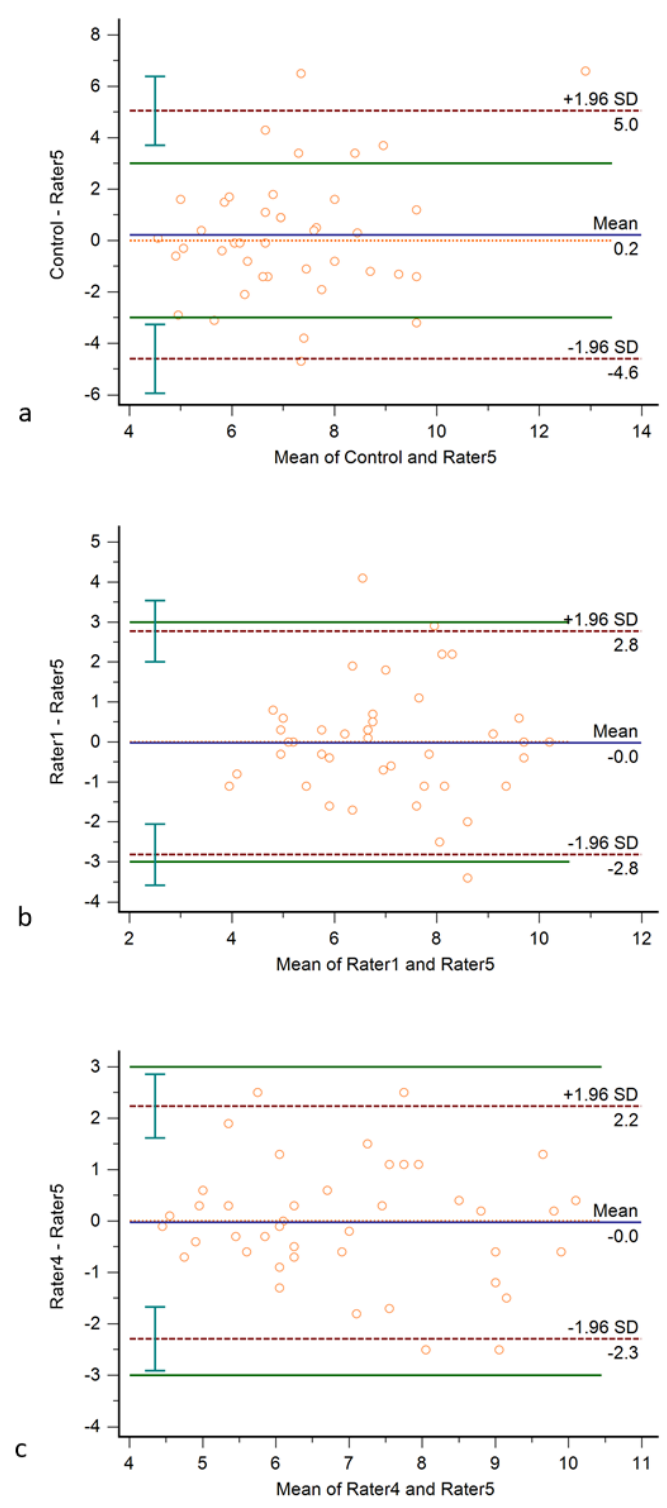
Figure 2. Bland–Altman plots of ( a ) control rater/reference, ( b ) trained novice/reference, and ( c ) experienced rater/reference. Bland–Altman plots include the mean difference (blue), limits of agreement (red dotted line) with an approximate 95% CI of the limits of agreement, and the maximum tolerated difference (green line).